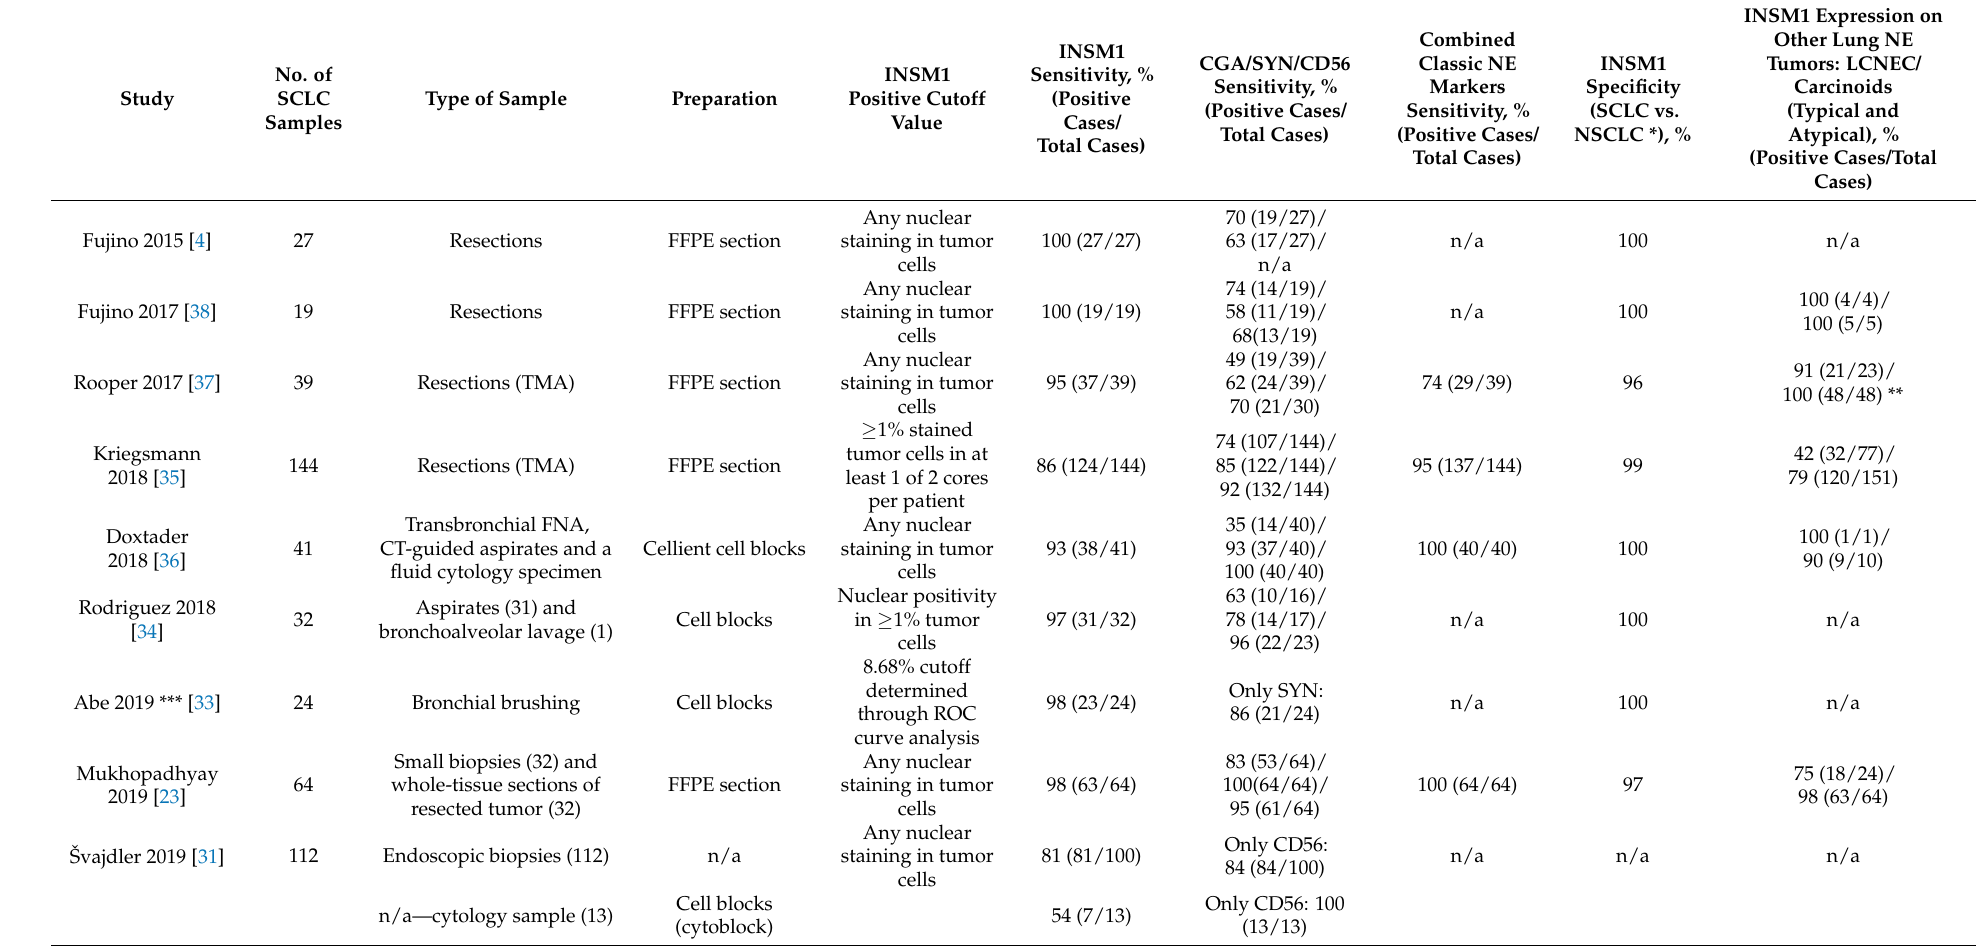
Table 1. INSM1 immunochemistry for small cell lung cancer diagnosis—retrospective analysis since